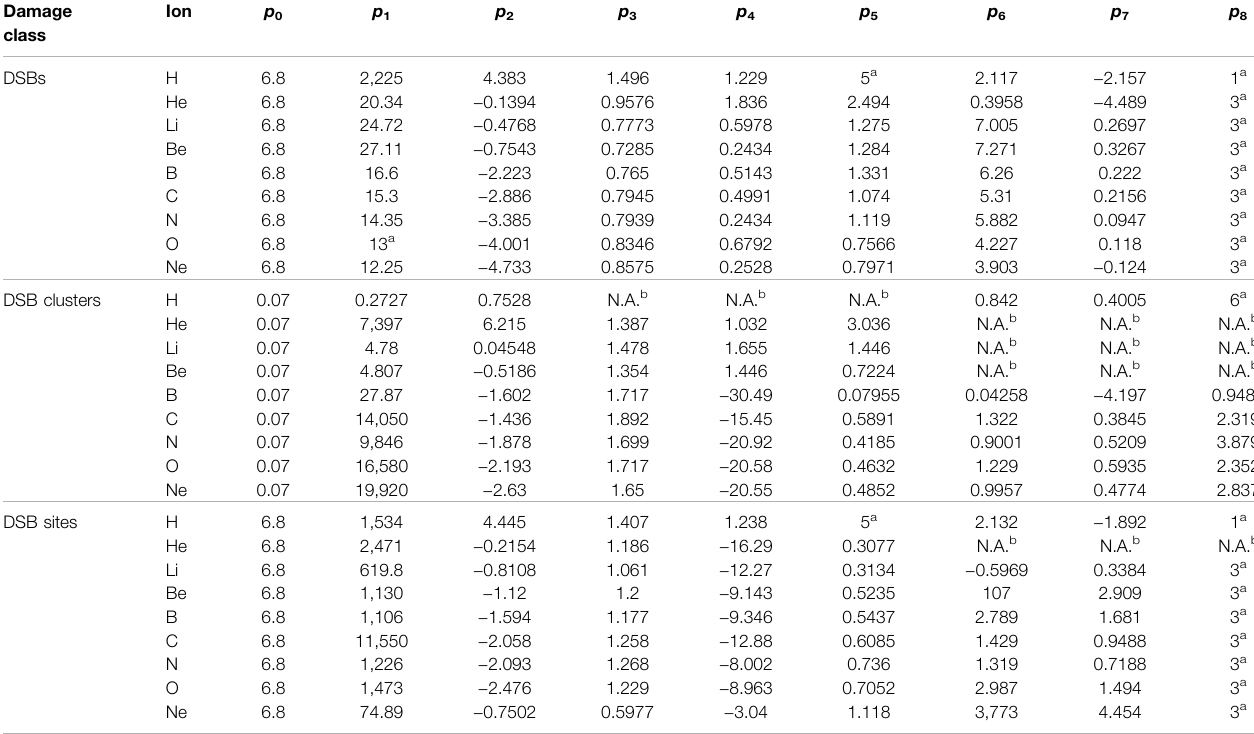
TABLE2| Parametersofanalyticalfunctions( Eq.2 )describingtheyieldsofDSBs,DSBclustersorDSBsites(expressedperGyperGbp)asafunctionoftheparticlestarting energy (in MeV/u). Damage